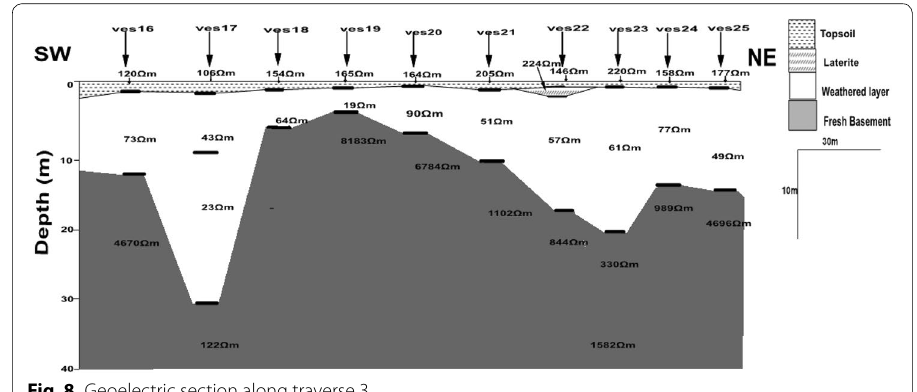
Fig. 8 Geoelectric section along traverse